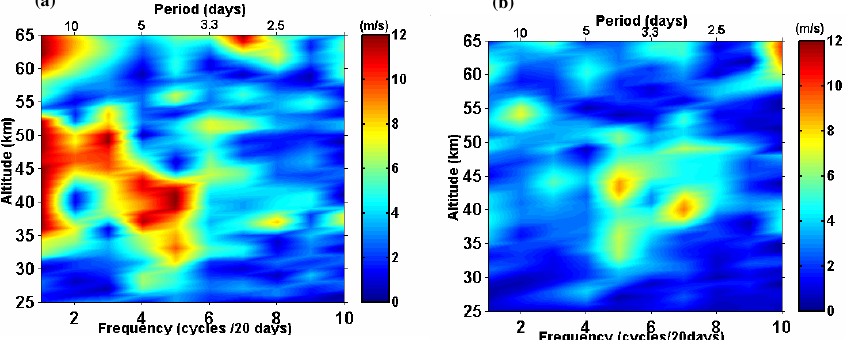
Fig. 3. Height-frequency plot of amplitudes of (a) zonal and (b) meridional wind fluctuations.